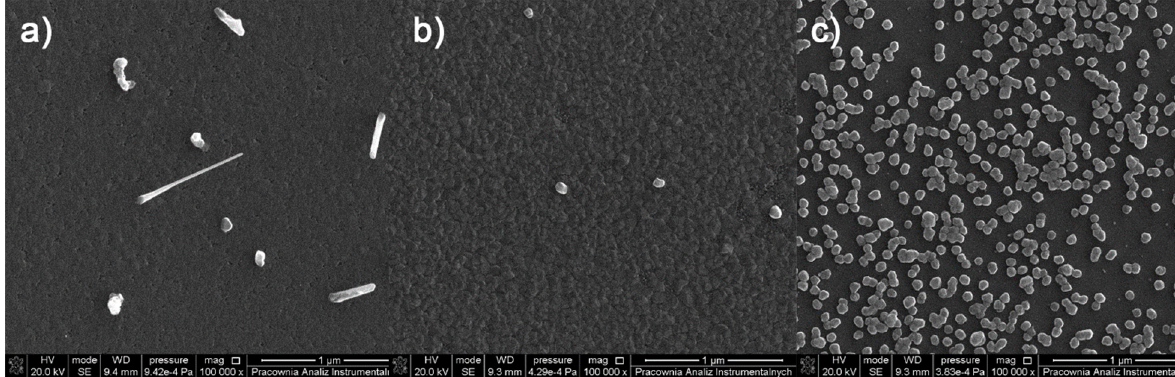
Figure 7. SEM images of deposits for the precursor [Cu 2 (EtNH 2 ) 2 (µ-O 2 CCF 3 ) 4 ] ( 1 ), Mag = 100,000× (( a – c )—orderly with the increasing transport way), T V = 473 K, T D = 573 K, Si(111), Ar.